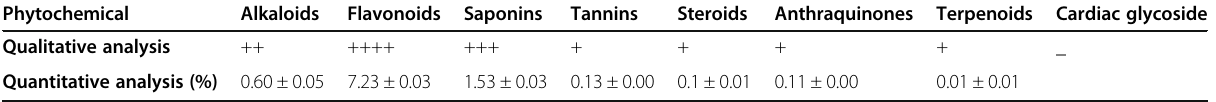
Table 3 Qualitative and quantitative phytochemical screening of Pleurotus tuber-regium